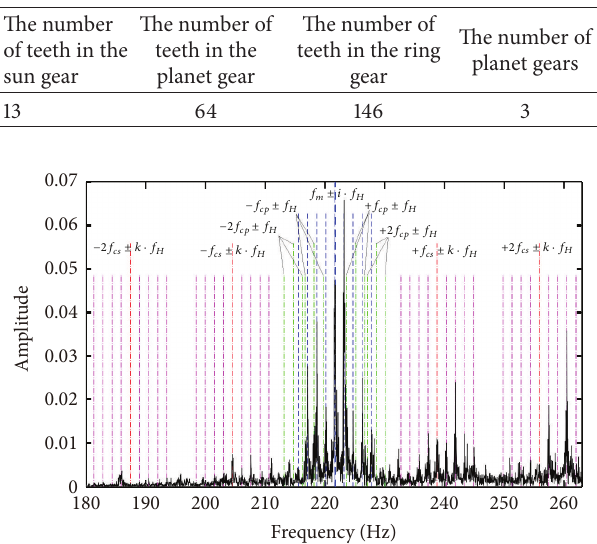
Figure6: Frequency spectrum of vibration signal collected from the planetary gearbox.